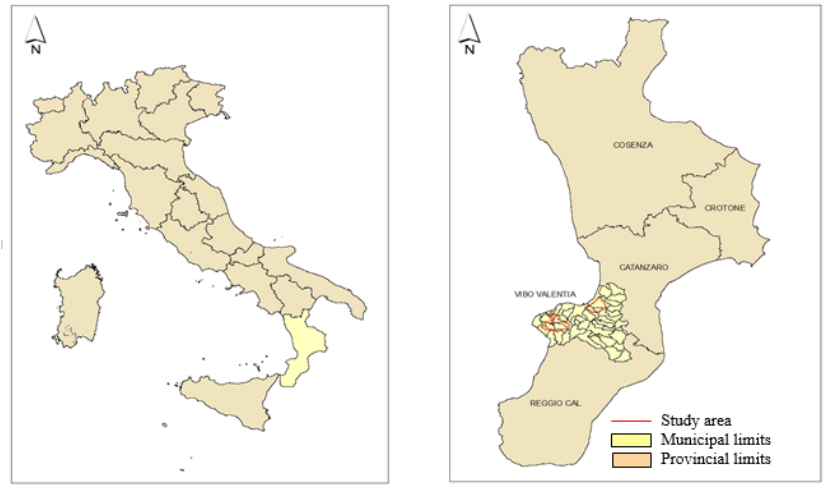
Figure 1. Study areas in the province of Vibo Valentia.